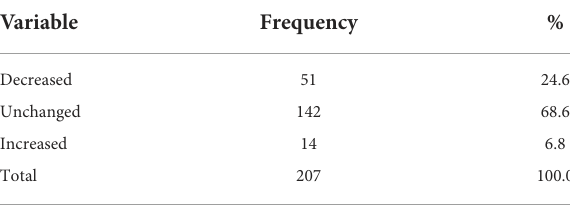
TABLE 10 Summary statistics of the amount of food wasted and thrown away.